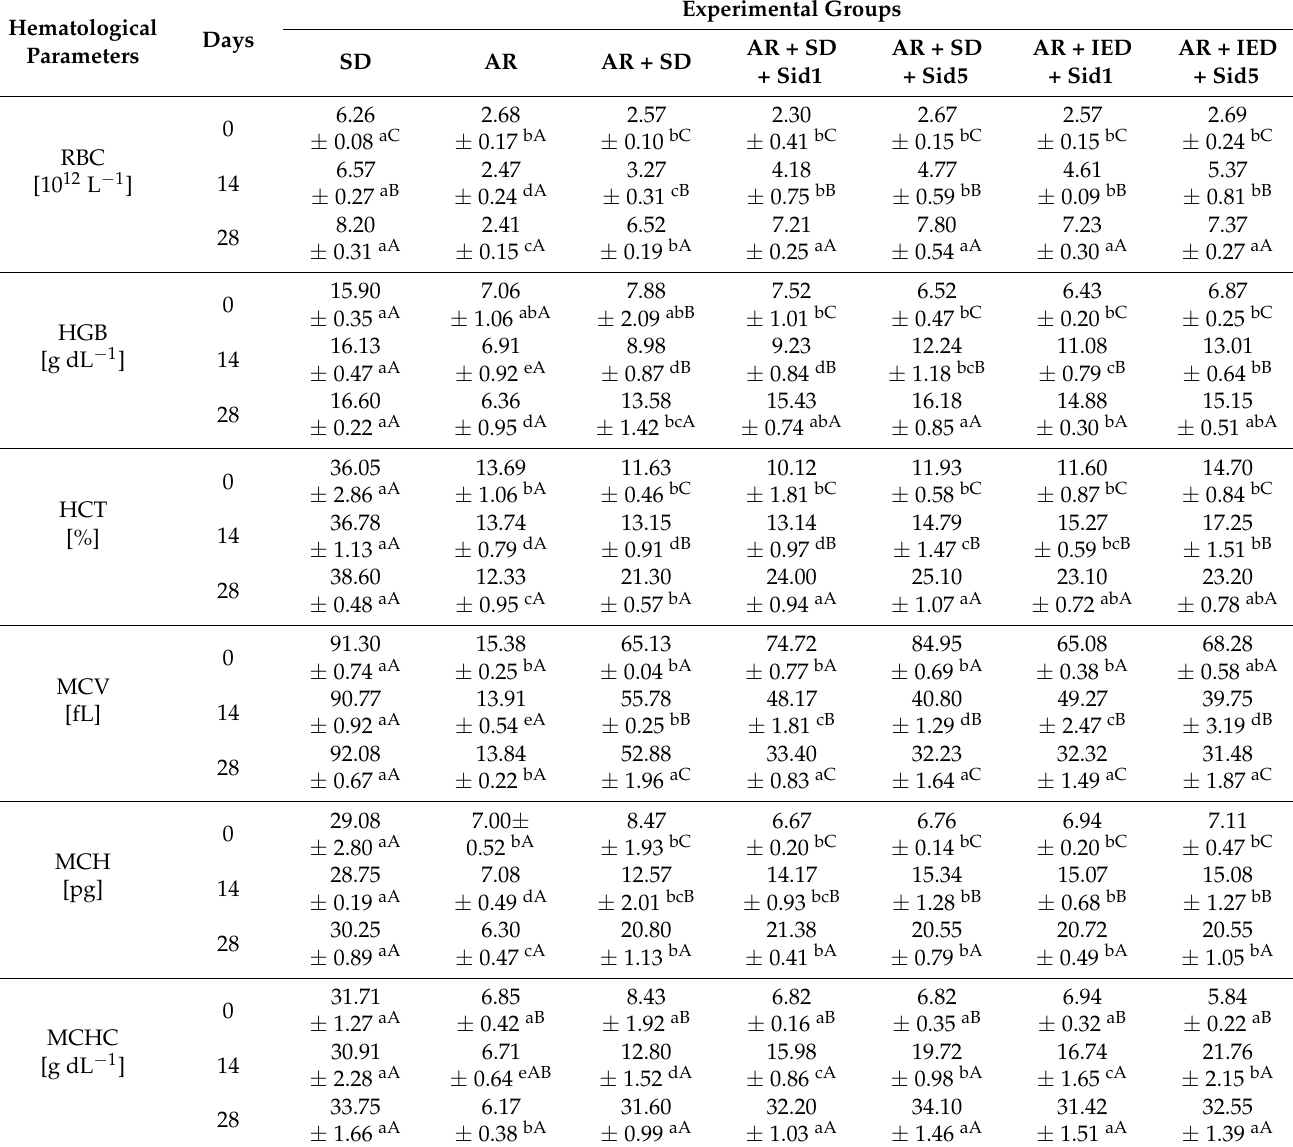
Table 4. Hematological parameters of rats fed different formulated experimental diets with an intraperitoneal injection of Sid at 1 and 5 µ g Kg − 1 at starting and recovery period up to 28 days ( n =